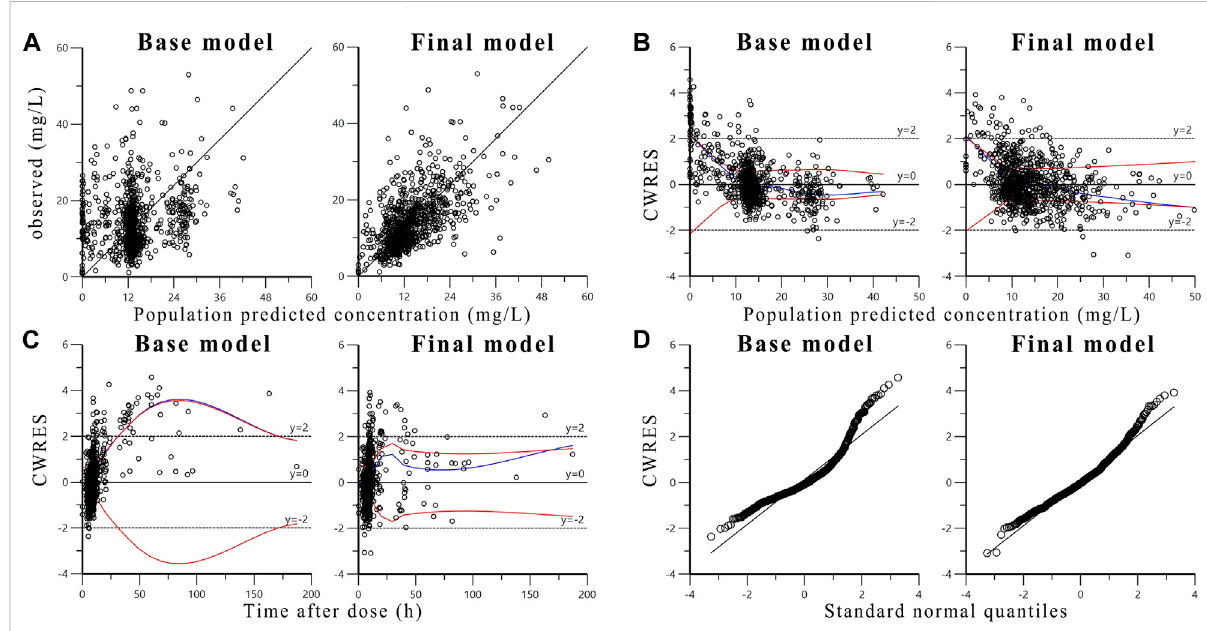
FIGURE 1 Diagnostic goodness-of- fi tplots of basemodeland fi nalmodel: (A) The observed concentrations versus population predicted concentrations; (B) Theconditionalweightedresiduals(CWRES)versuspopulationpredictedconcentrations; (C) Theconditionalweightedresidualsversustimeafter dose; (D) The conditional weighted residuals versus standard normal quantiles. The blue line is the overall trend of data fi tting, the two red lines are the absolute value distribution of the data and its mirror image,